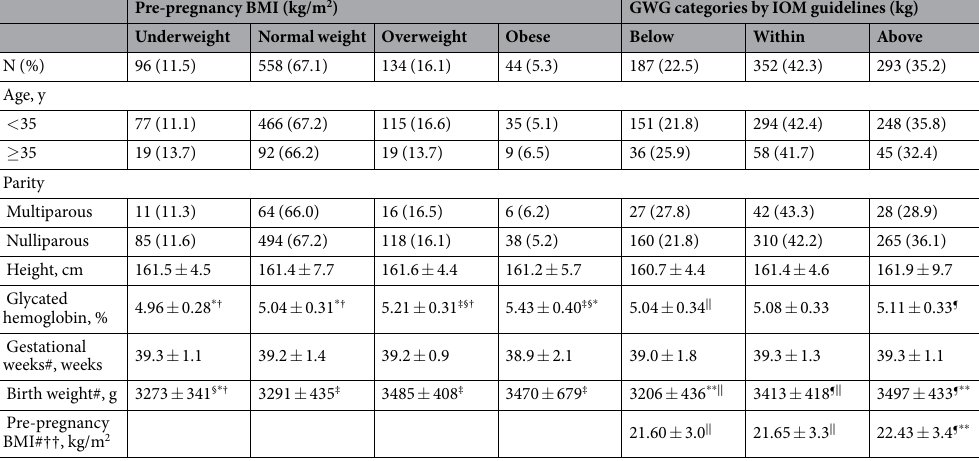
Table 1. Clinical characteristics of the study participants grouped by pre-pregnancy body mass index and gestational weight gain. Data presented as n (%) or mean ± standard deviation. BMI, body mass index; GWG, gestational weight gain; IOM, Institute of Medicine. * P < 0.05 vs. overweight group; † P < 0.05 vs. obese group; ‡ P < 0.05 vs. underweight group; § P < 0.05vs. normal weight group; || P < 0.05 vs. excessive (‘above’) GWG group; ¶ P < 0.05 vs. inadequate (‘below’) GWG group; # variance is non-homogeneous; ** P < adequate (‘within’) GWG group; †† The Correlation coefficient between Pre-pregnancy BMI and GWG is − 0.283, P <